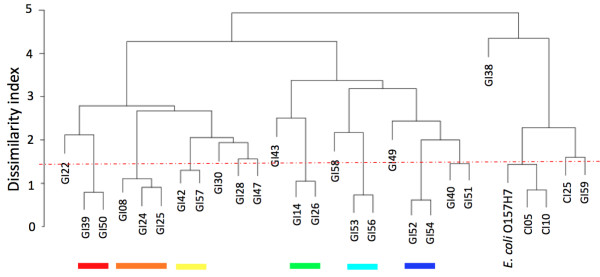
Clustering of the 24 Genomic Islands > 10 kb in Escherichia coli O157H7 strain Sakai in seven clusters and nine singletons. Below the cut-off value (red line; dissimilarity < 1.44, see Additional File 2), seven clusters are identified (six clusters with two GIs, and one with three GIs), with a total of 15 Genomic Islands (indicated with seven colored bars). The GIs and their numbers are identified in Additional File 5.